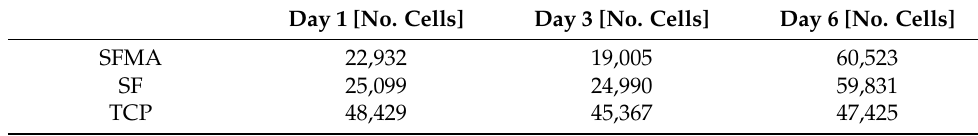
Table 1. Number of cells values obtained from the Pico Green test. Day 1 [No. Cells] Day 3 [No. Cells] Day 6 [No. Cells] SFMA 22,932 19,005 60,523